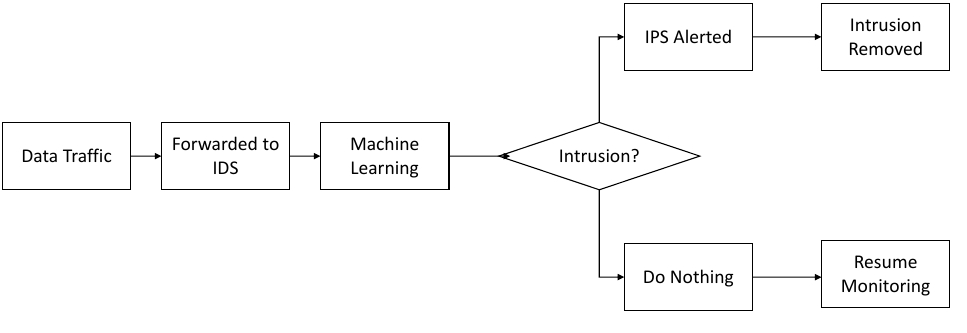
Figure 1. Interactions between IDS and IPS.